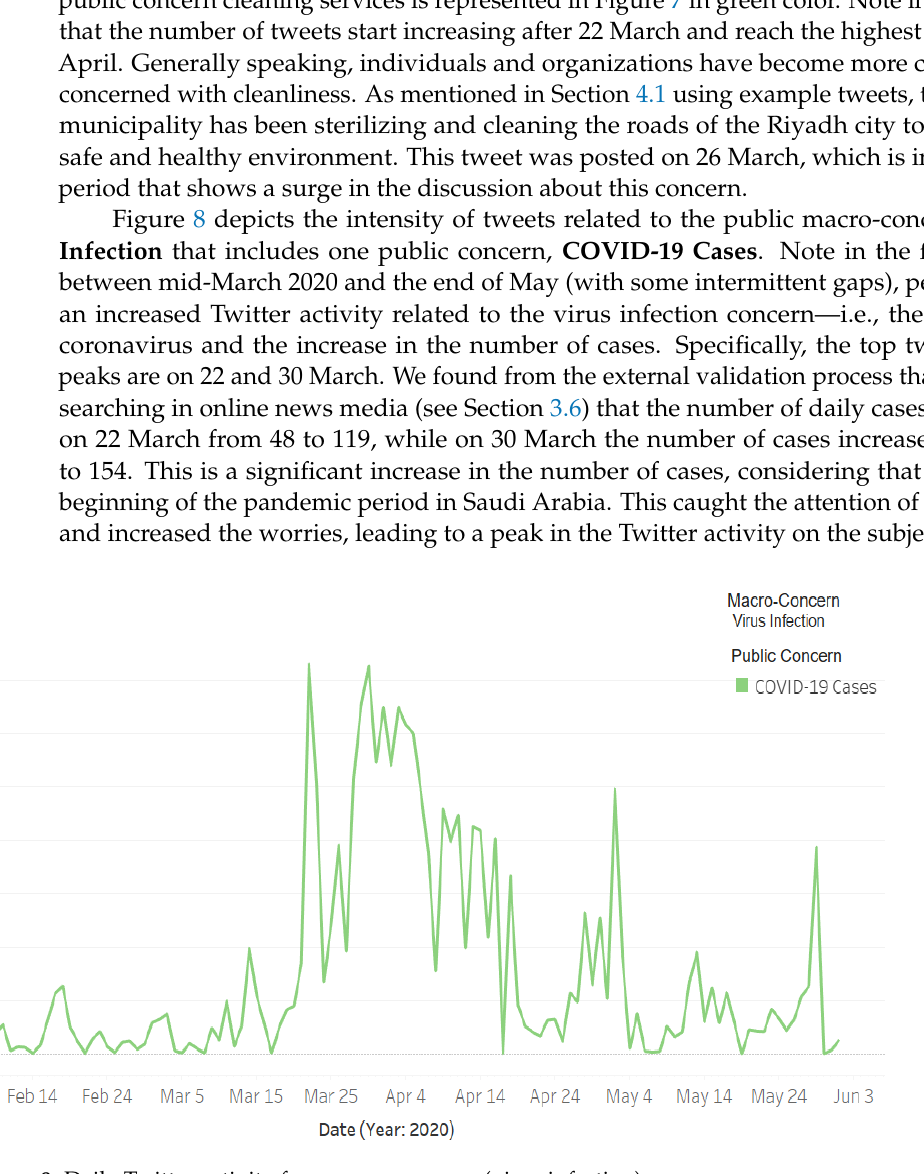
Figure 9. Daily Twitter activity for a public macro-concern (back to normal). This tweet was posted by the end of the nationwide coronavirus curfew. The Ministry of Health considered it the first stage to return to normal and started a new awareness campaign under the slogan “ رذحب ةدوعلا ” (returning with caution). The interaction of